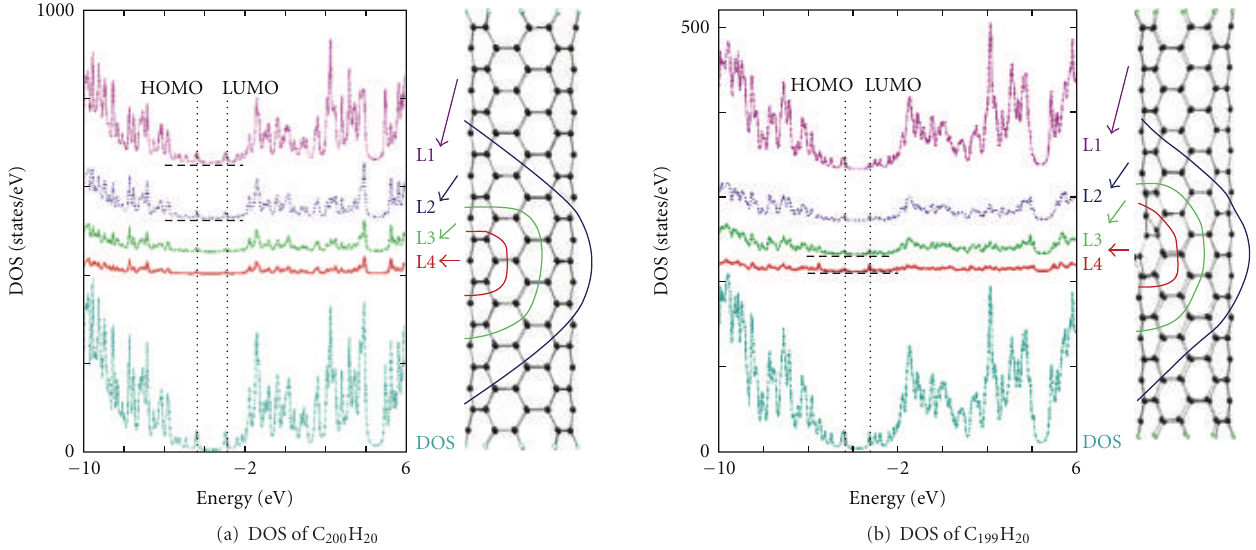
Figure 6: Optimized geometries, DOS, and LDOS of (a) C 200 H 20 ( ε HOMO = − 4 . 35 eV, ε LUMO = − 2 . 97 eV) and (b) C 199 H 20 ( ε HOMO = = − 3 . 37 eV). L1 − L4 are the LDOS for the specified layer of atoms − 4 . 21 eV, ε LUMO